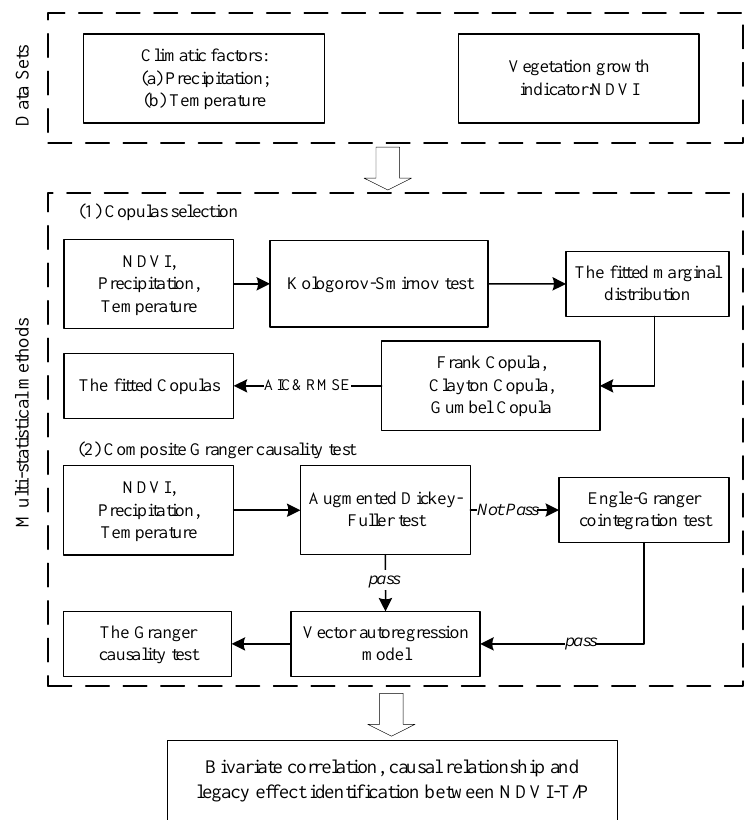
Figure 4. The schematic of the multi-statistical flowchart for vegetation in response to temperature and precipitation ((1) and (2) are the two components for multi-statistical method).